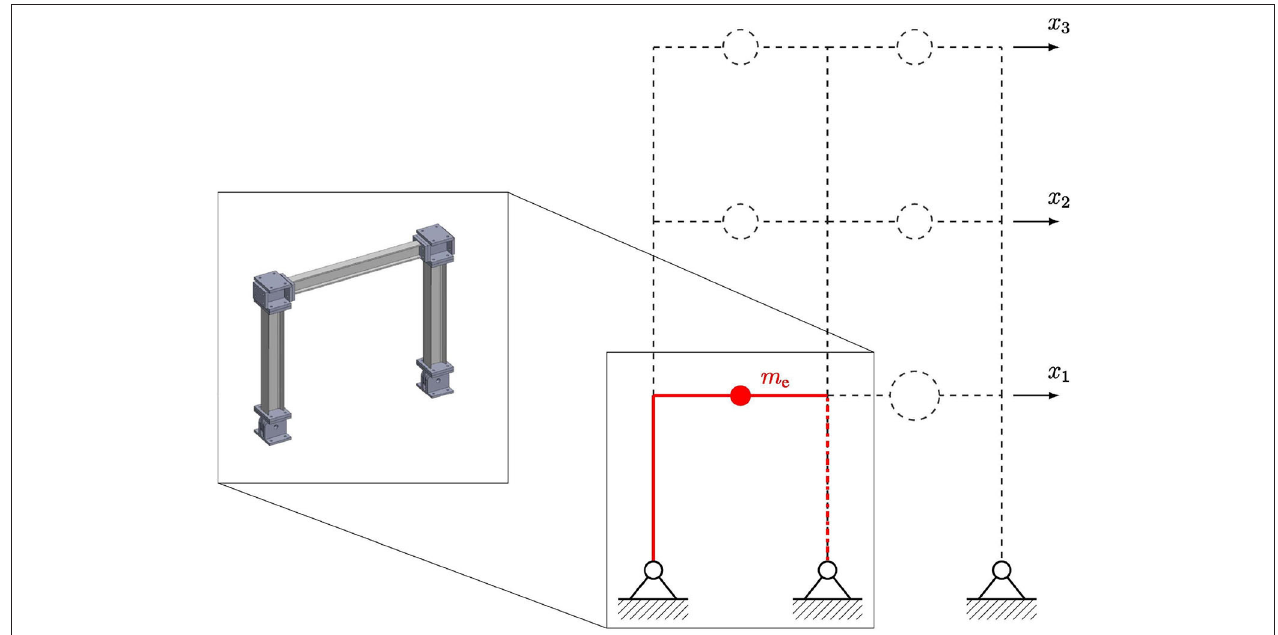
FIGURE 4 | The reduced 3-DOF benchmark frame and its partitioning into an experimental and a numerical substructure. Reproduced from Silva et al. (2020) with permission from Elsevier.